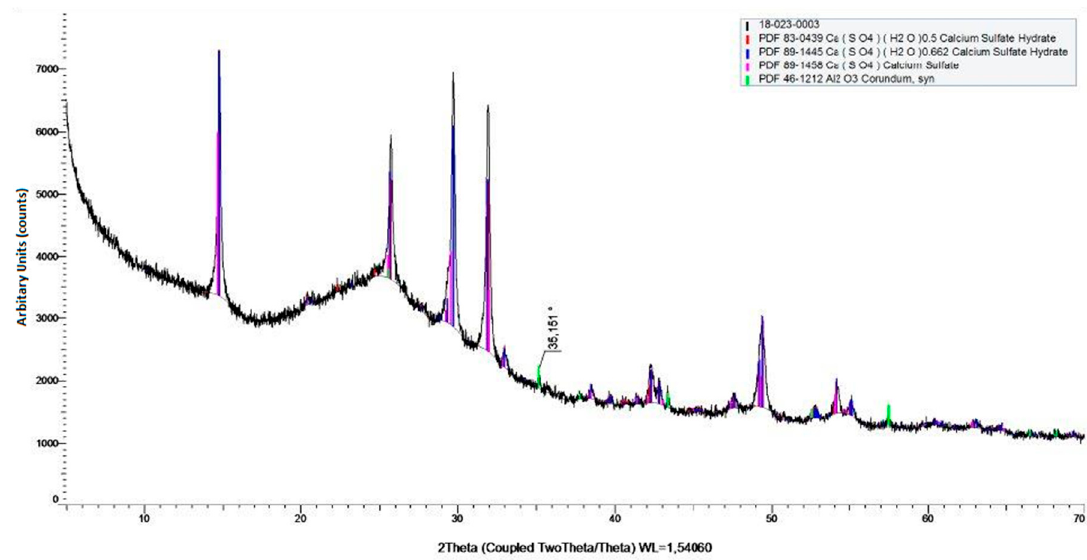
Figure 6. XRD analysis of the precipitation product.